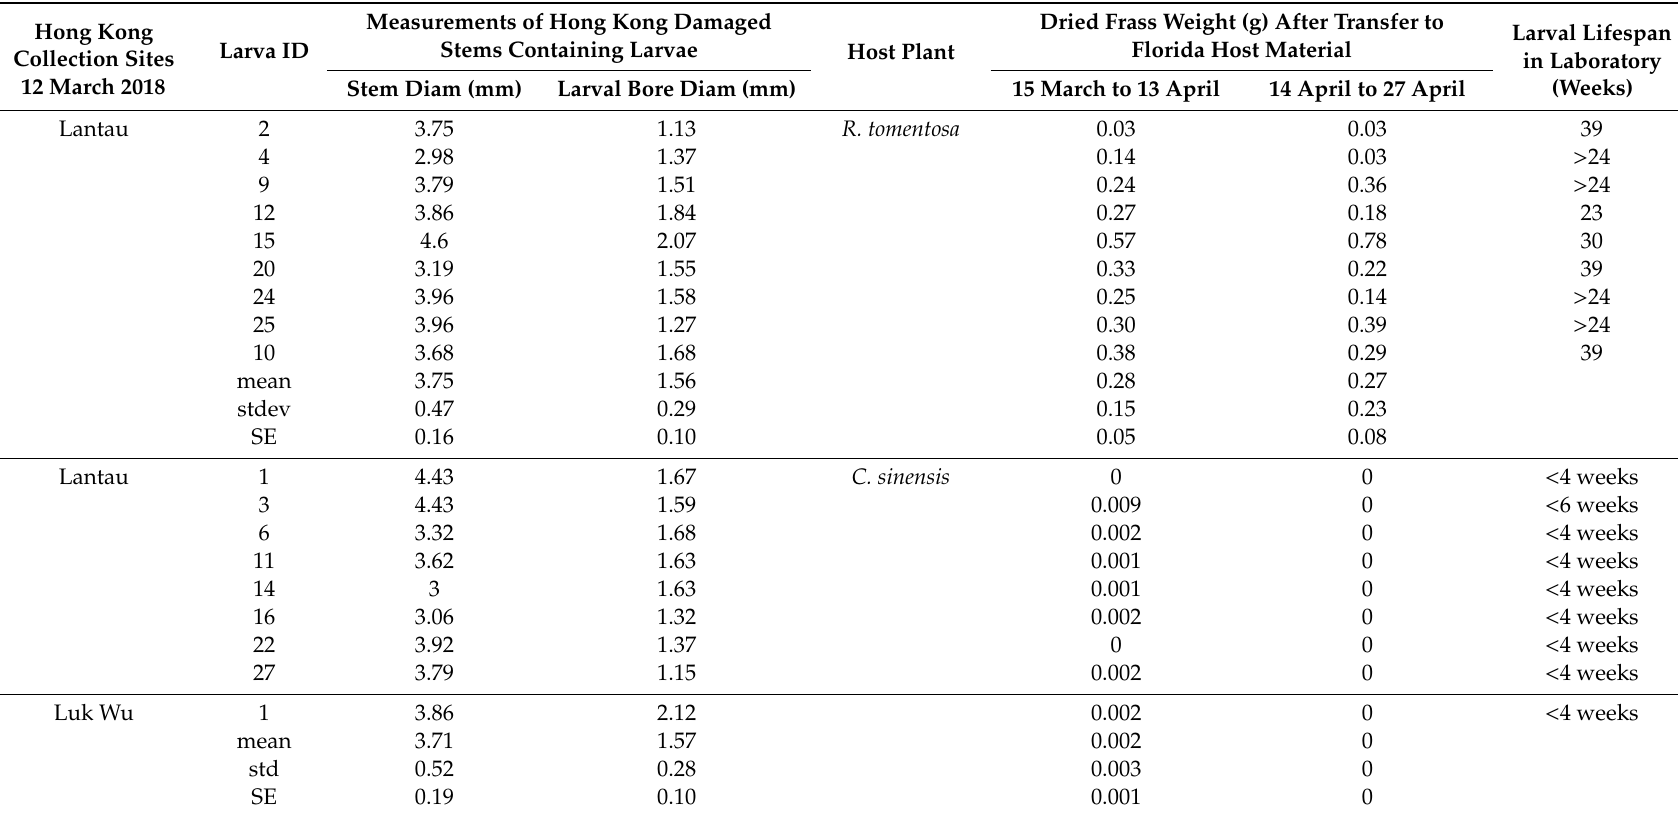
Table 2. Comparison of proximal stem diameter and stem bore diameter of 2018 field-collected C. subagronoma larval stems. The larvae were transferred to Florida R. tomentosa and C. sinensis on March 15 ( N = 3 / species), March 16 ( N = 5 / species), March 19 ( N = 1 to C. sinensis ), and March 23 ( N = 1 to R. tomentosa ) and their subsequent frass production and longevity under greenhouse